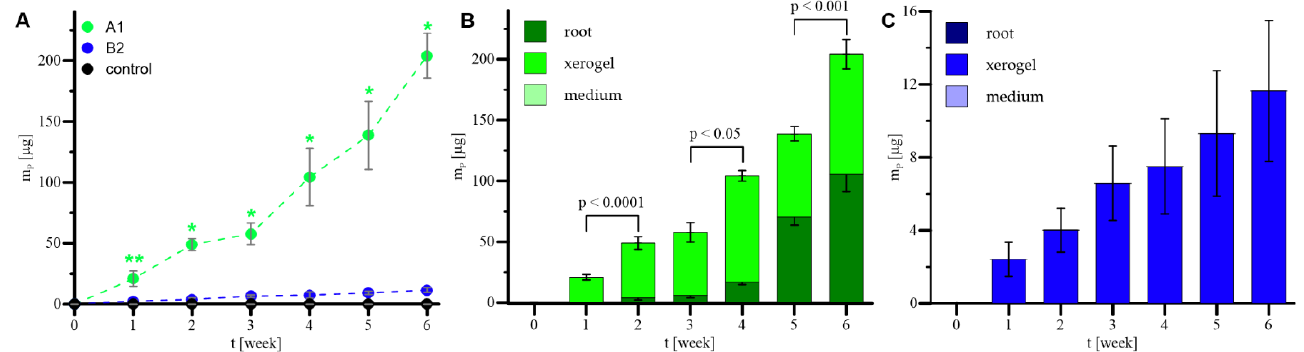
Figure 9. Values of m P obtained for the prolonged 42-day (i.e., 6-week) cultures of R. graeca hairy roots supported with xerogels A1 and B2 xerogels, and the control culture: general comparison of the culture systems ( A ), detailed presentation of summarized production of deoxyshikonin including bioproduct accumulated in root biomass, xerogel and culture medium taken from systems supported with xerogels A1 ( B ) and B2 ( C ). The green asterisks mark the culture with gel A1 at which the determined values of studied parameters were statistically different from those for the B2 culture system. The number of asterisks identifying the value of p ( p < 0.001 (**) and p < 0.0001 (*)), as well as the p values over brackets, were determined according to the ANOVA